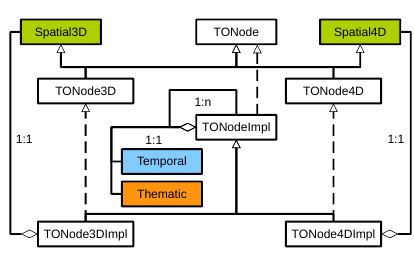
Figure 2. Spatial and spatio-temporal model